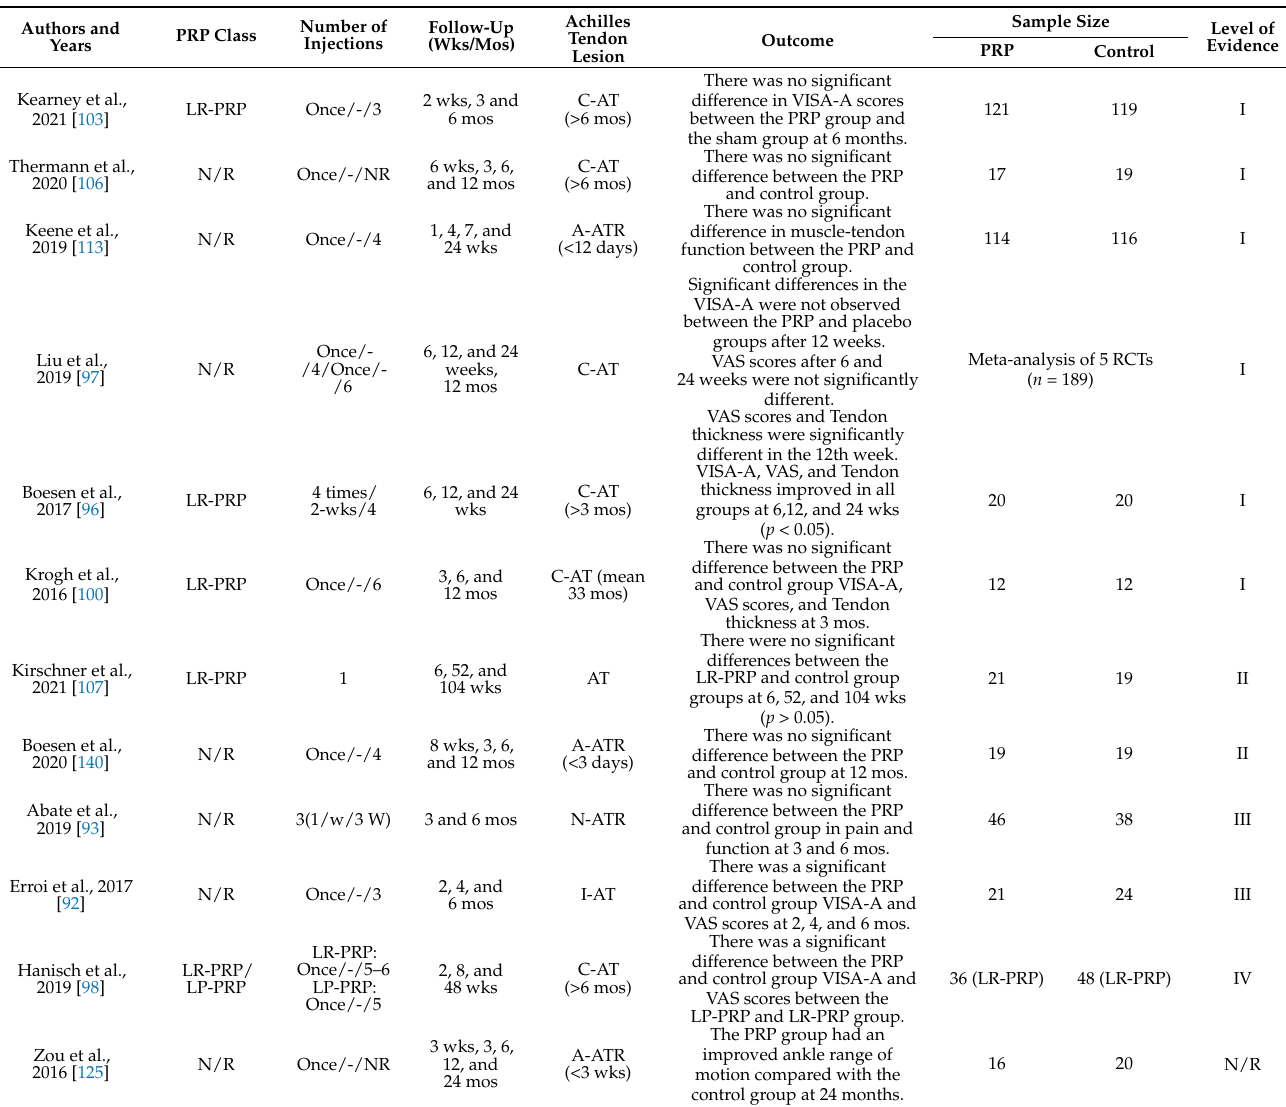
Table 3. Studies on the use of PRP application in foot and ankle for Achilles tendon